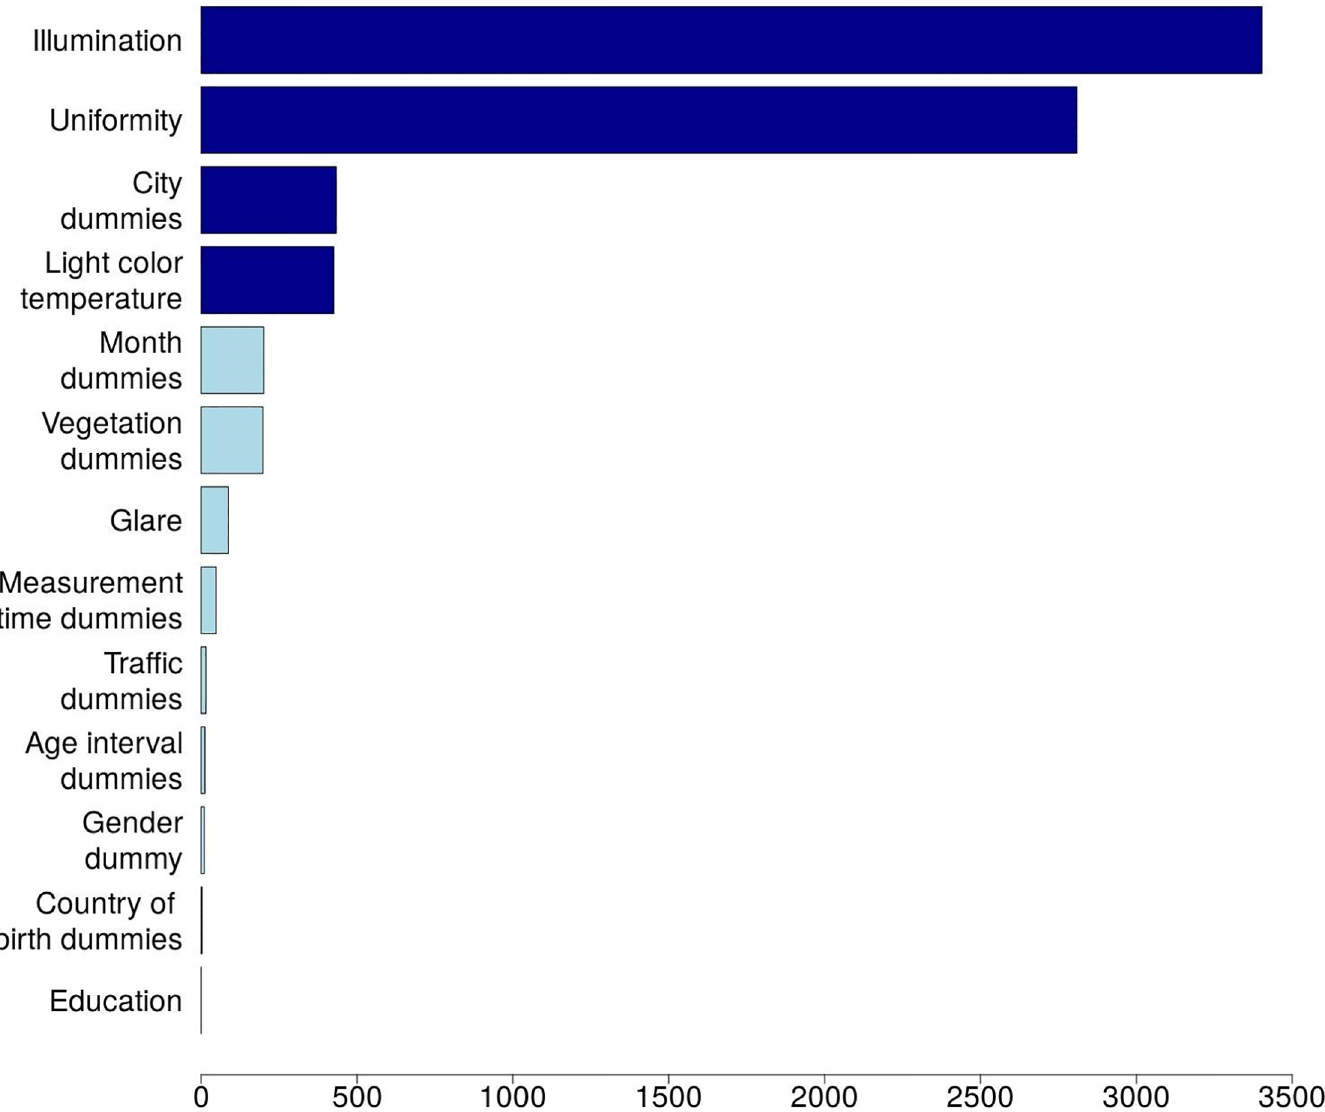
Fig 5. Relative contribution of different factors to FoS (the AIC increment test). Note: based on calculates reported in Table 6; see Table 1 for variables’ definitions; darker bars mark four most important variables, discussed in the text in some detail.